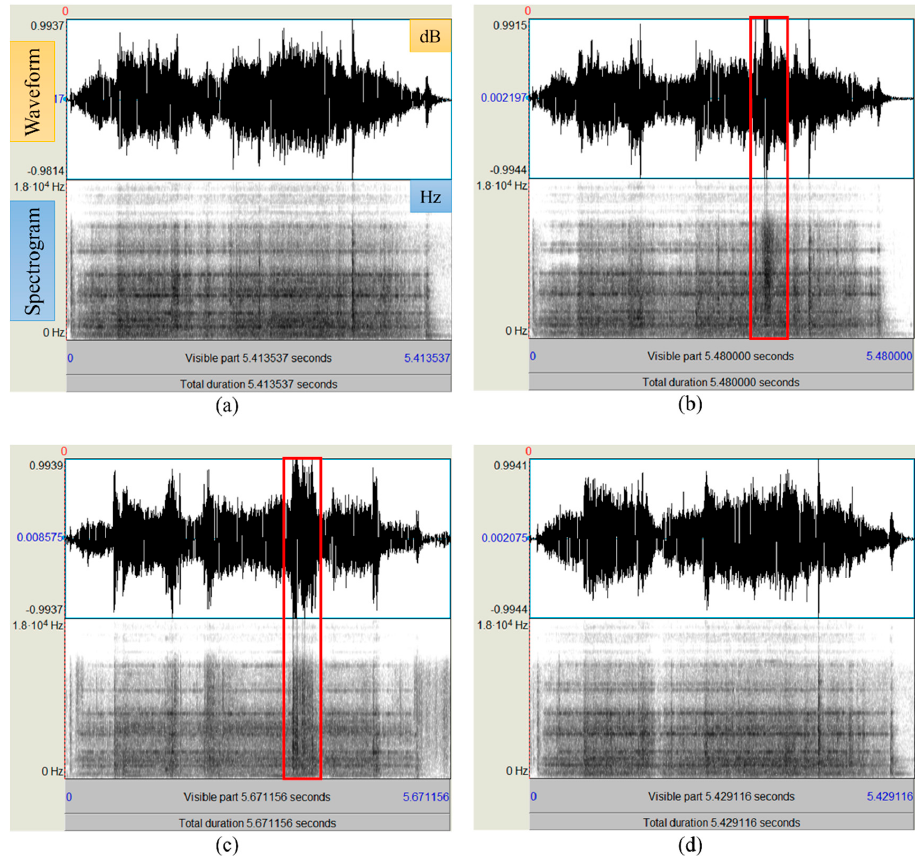
Figure 10. Waveforms and spectrograms for fault and normal sound samples (the rectangle indicates the sound pattern changes at the point of contact between the rod and the obstruction): ( a ) normal; ( b ) ice obstruction; ( c ) ballast obstruction; and ( d ) slackened nut.